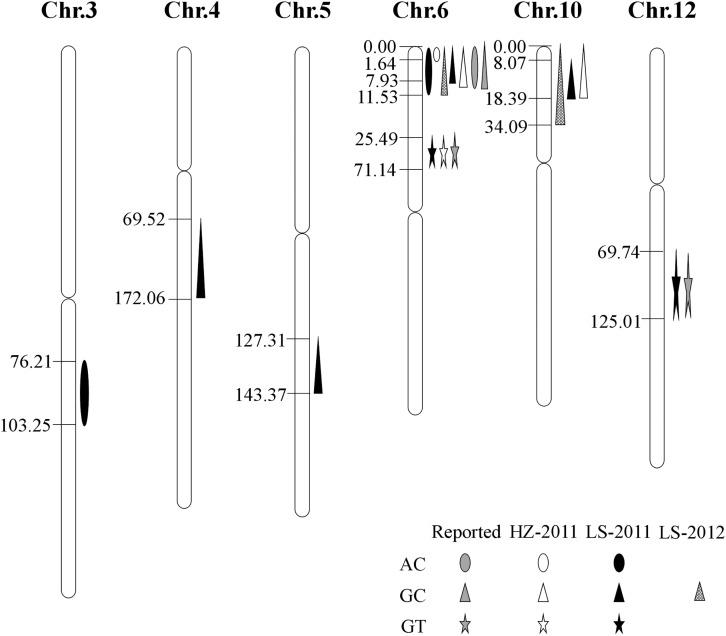
Location of QTLs for AC, GT, and GC on SNP map. Number indicates genetic distance (cM) along each chromosome.